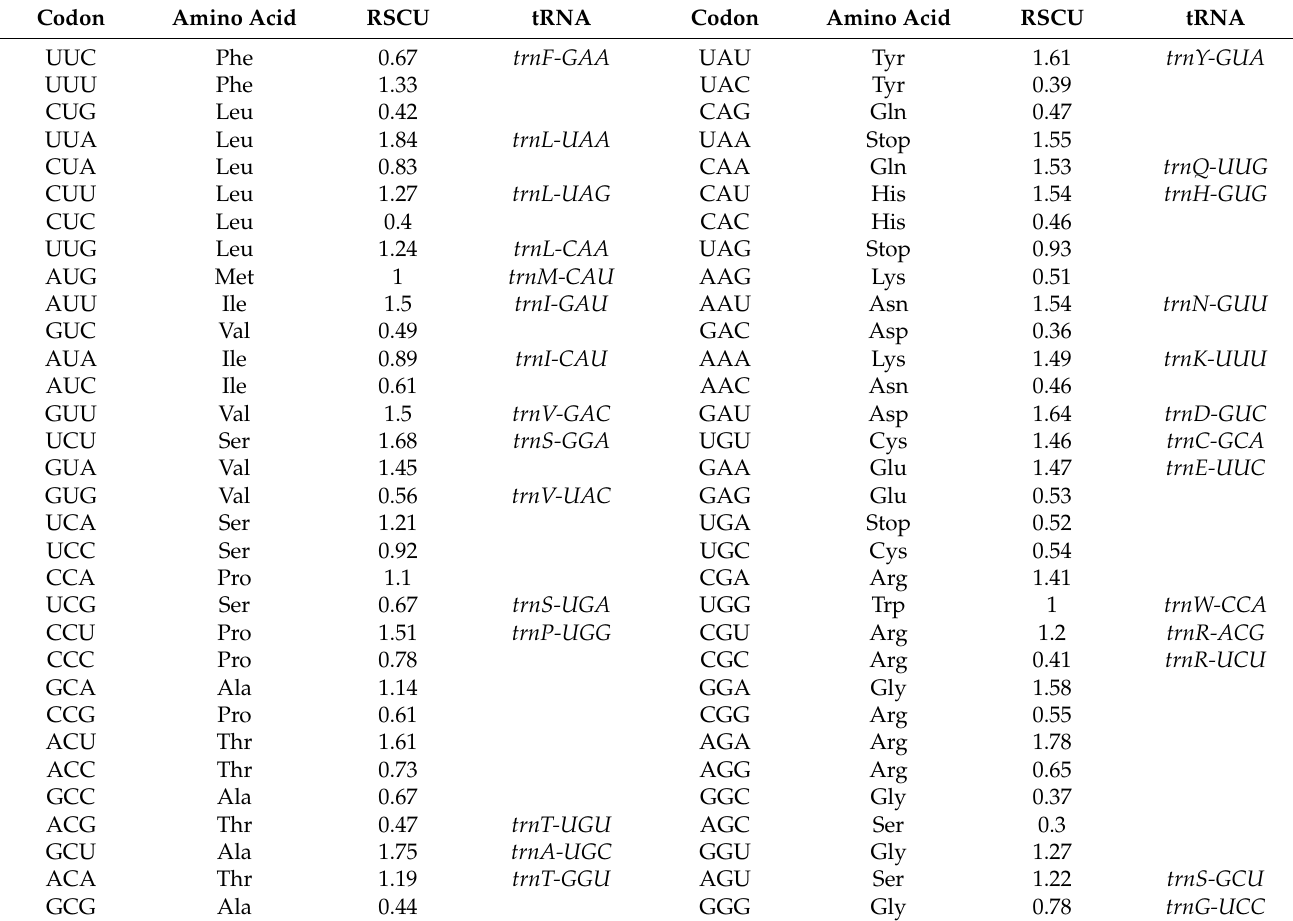
Table 4. Codon usage of the H. forskaolii chloroplast